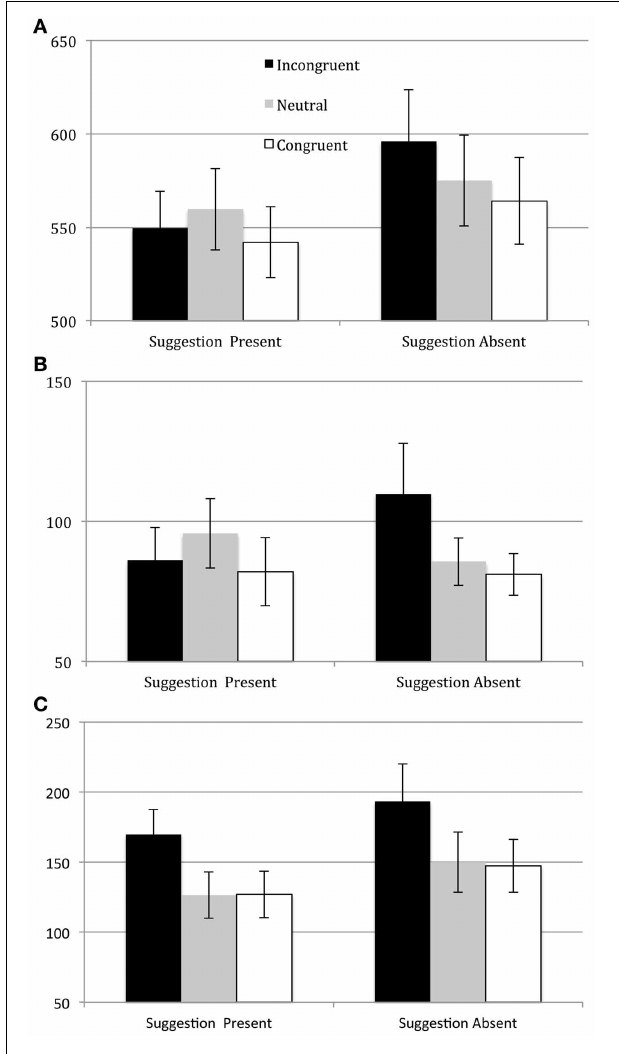
p > 0 . 9 (0.37) FIGURE 1 | (A) Values for μ (A) , σ (B) , and τ (C) in milliseconds as a function of condition (collapsing across the Response-Stimulus Interval